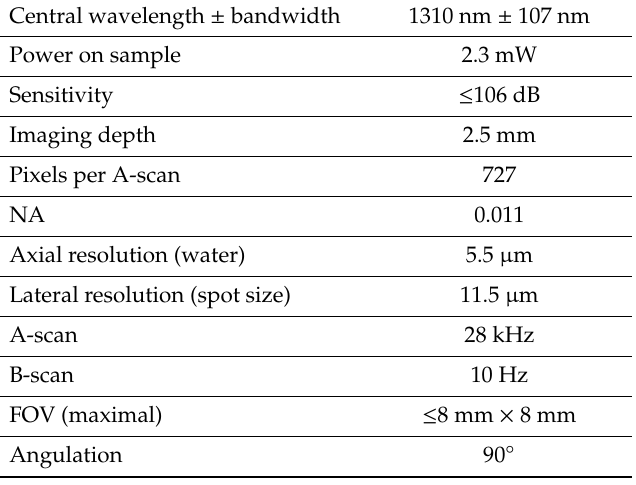
Table 1. Parameters of the optical coherence tomography (OCT) probe (IOS: OCTH ‐ 1300NR ‐ SP6).